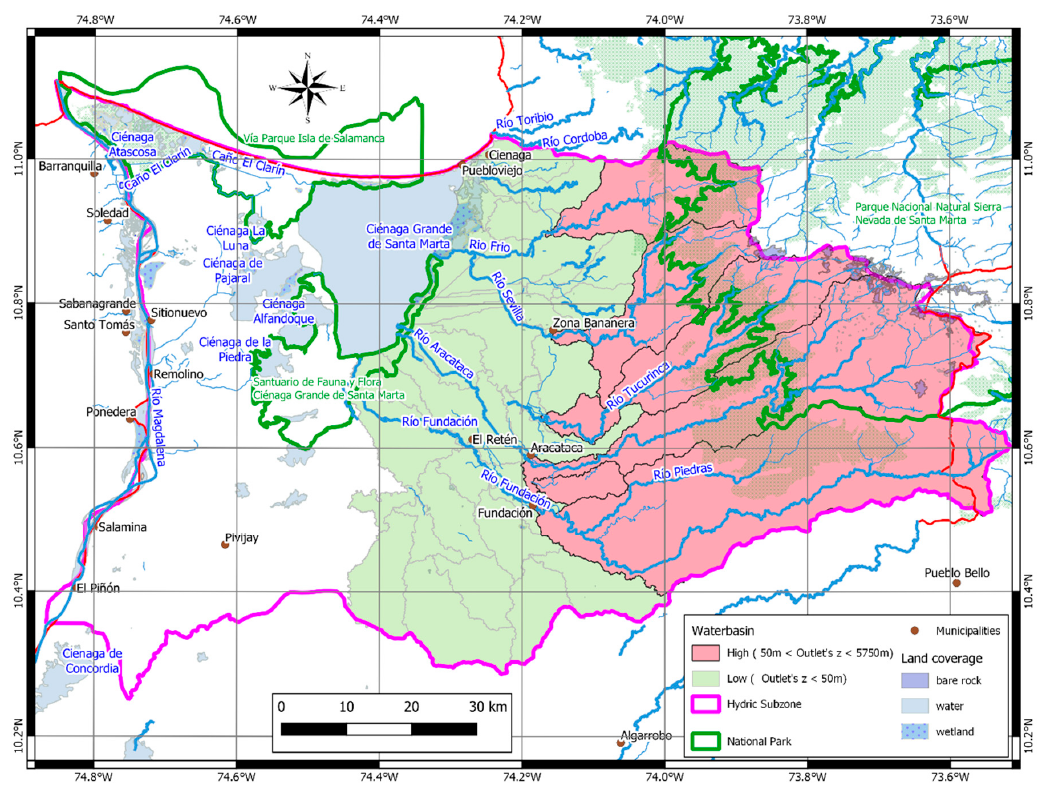
Figure 2. Basins contributing to the water balance of CGSM.